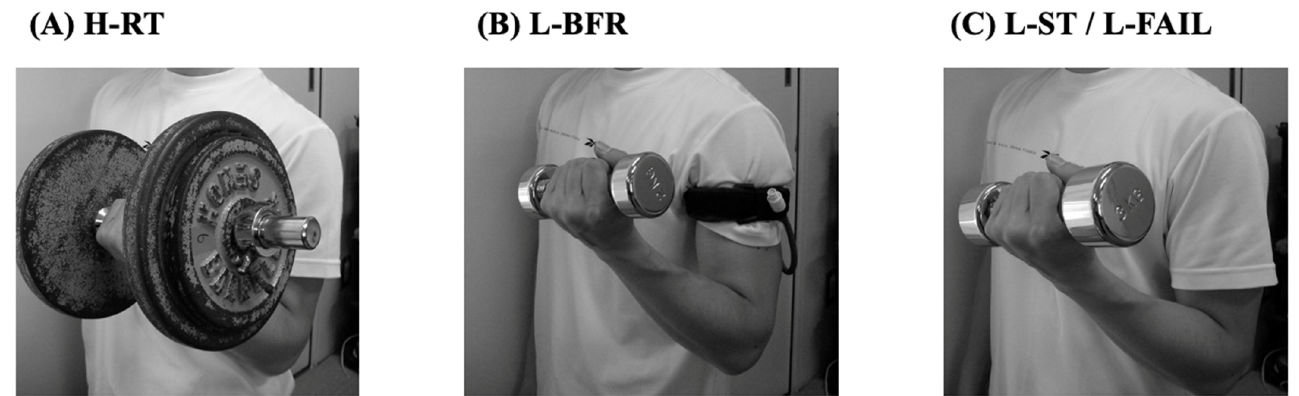
Figure 1. Pictures show a comparison of resistance training of the biceps brachii in each style when using free weights ( A – C ). H-RT, high-load (at 70–80% one repetition maximum (1RM)) resistance training. L-BFR, low-load resistance training (at 20–30% 1RM) with blood flow restriction by an elastic designed cuff belt. L-ST, low-load (at 20–30% 1RM) resistance training with relatively slow movement and tonic force generation. L-FAIL, low-load (at 20–30% 1RM) resistance exercise to volitional fatigue.